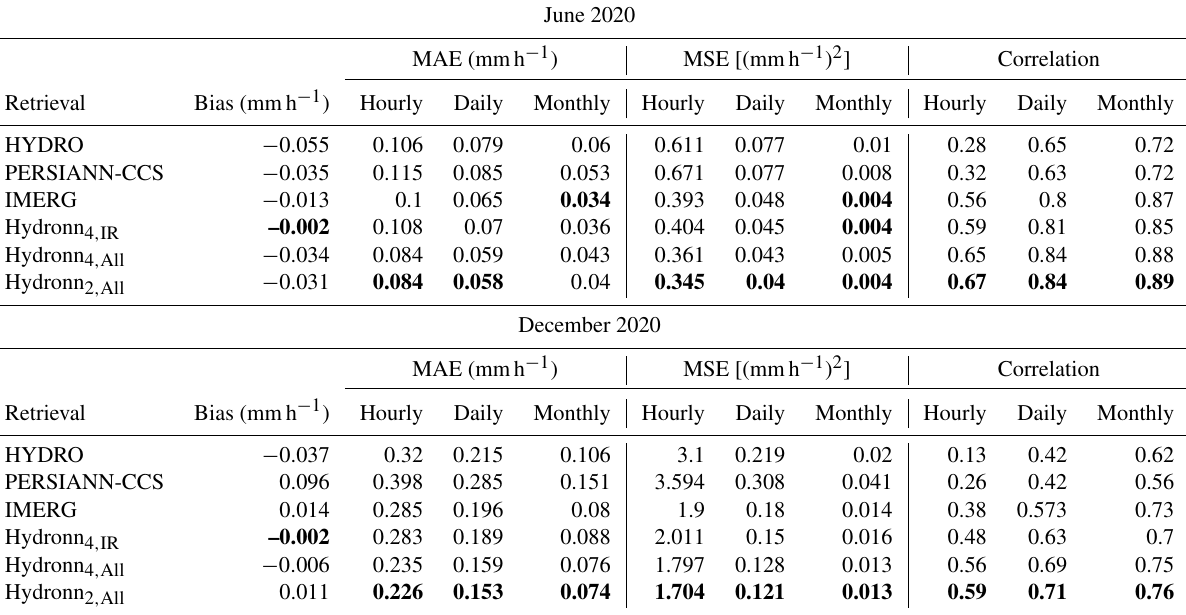
Table 3. Accuracy metrics for the retrieved mean precipitation compared to gauge measurements at different timescales. The best values in each column are marked using bold font. Definitions of all metrics are provided in Appendix